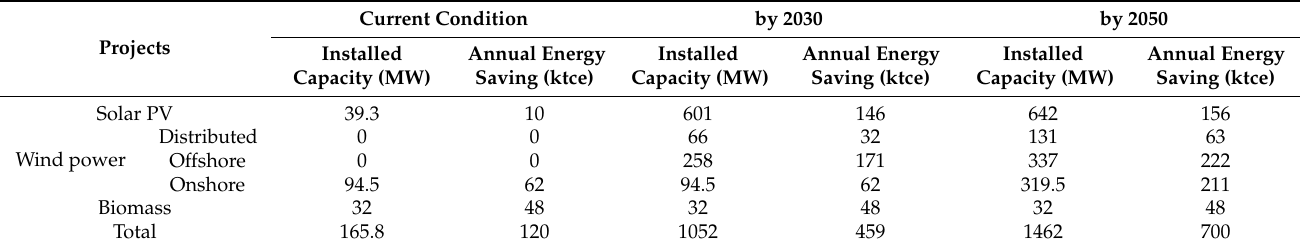
Table 16. Current and planned renewable energy conditions.